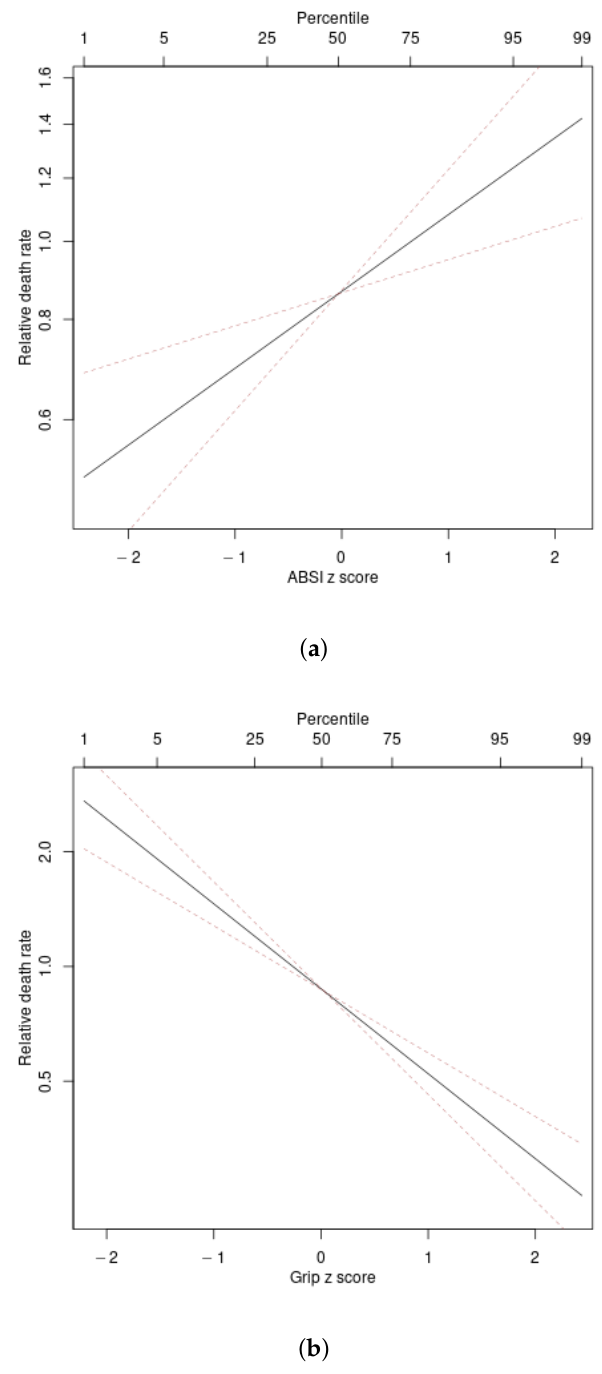
Figure 2. Estimated mortality hazard ratio in NHANES 2011–2014 as a linear functions of ( a ) ABSI, ( b ) Grip Z score. Dashed lines indicate 95% confidence intervals. Percentiles are based on the NHANES 2011–2014 cohort. ABSI = a body shape index, Grip = hand grip